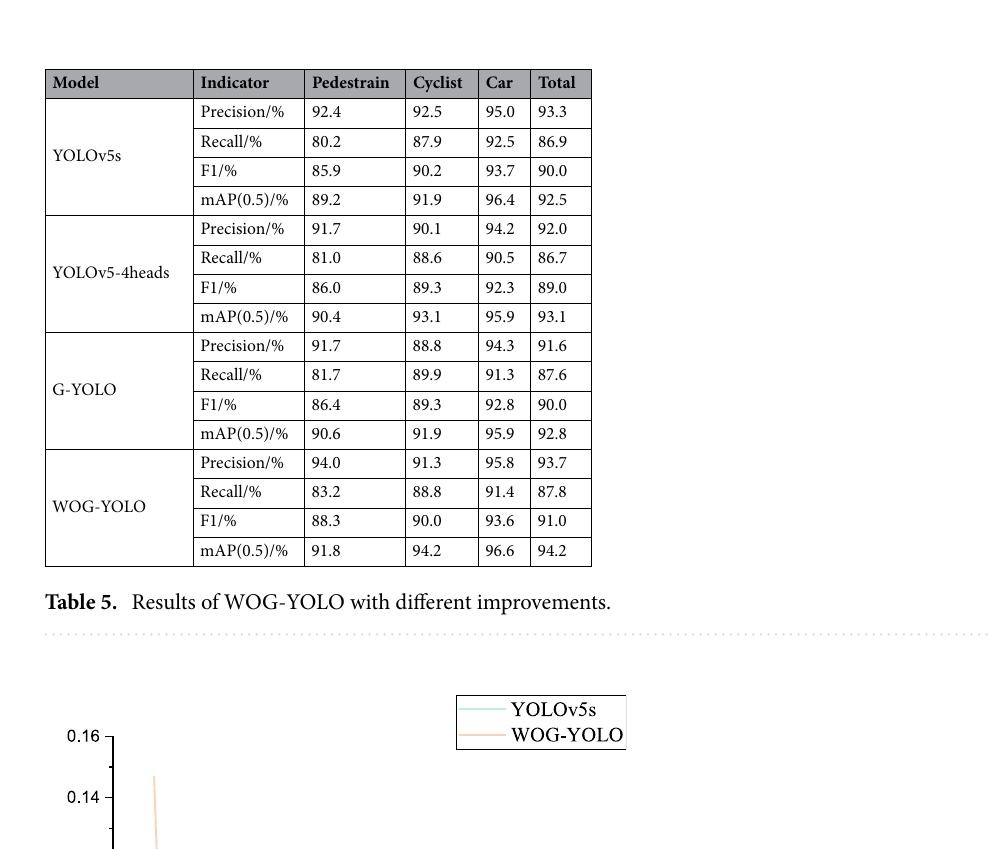
Table 4. Indicators of YOLOv5s, WOG-YOLO and other algorithms.